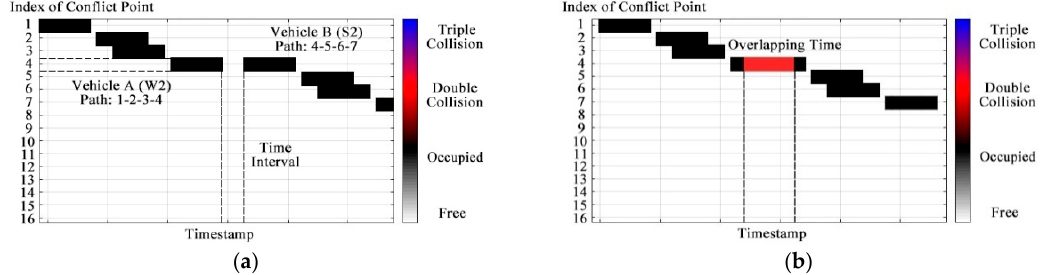
Figure 8. Samples of conflict-duration graph. ( a ) Collision-free; ( b ) collision.